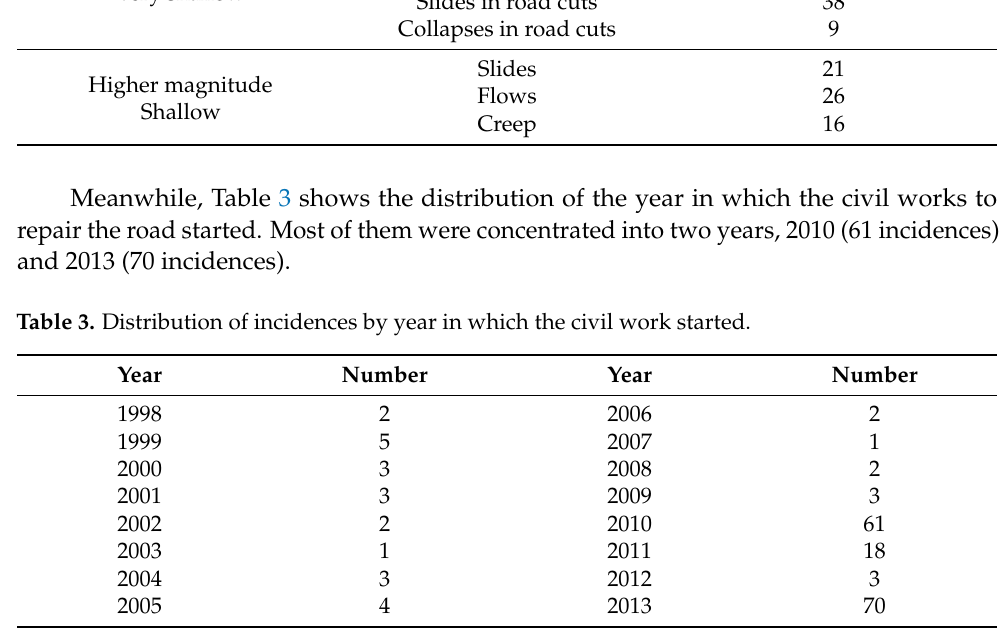
Table 2. Distribution of incidences by typologies. Magnitude Typology Number Gullies 46 Undercut in road Lower magnitude embankments Very shallow Slides in road cuts 38 Collapses in road cuts 9 Slides 21 Higher magnitude Flows 26 Shallow Creep 16